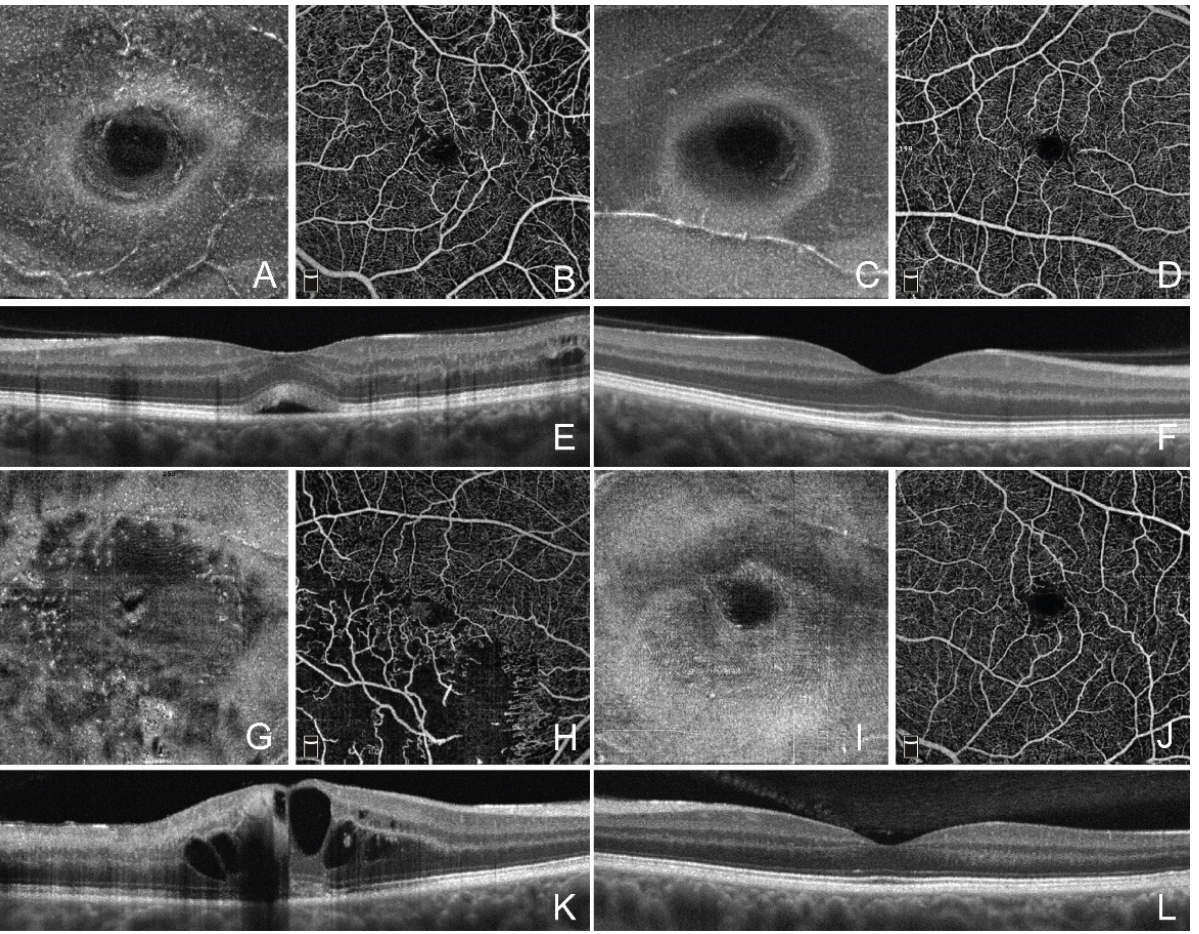
Figure 3. Optical coherence tomography angiography imaging of retinal macrophage-like cells in retinal vein occlusion with and without subfoveal fluid. ( A ) Structural en face optical coherence tomography angiography (OCTA) projection in the RVO eye with macular edema and subfoveal fluid. ( B ) En face OCTA projection of superficial capillary plexus slab. ( C ) Structural en face OCTA projection in the fellow unaffected eye. ( D ) En face OCTA projection of superficial capillary plexus slab in the fellow unaffected eye. ( E ) Cross-sectional OCT image showing macular edema and sub- foveal fluid in the RVO eye. ( F ) Cross-sectional OCT image showing normal macula in the fellow eye. ( G ) Structural en face OCTA projection in the RVO eye with macular edema and no subfoveal fluid. ( H ) En face OCTA projection of superficial capillary plexus slab. ( I ) Structural en face OCTA projection in the fellow unaffected eye. ( J ) En face OCTA projection of superficial capillary plexus slab in the fellow unaffected eye. ( K ) Cross-sectional OCT image showing macular edema without subfoveal fluid in the RVO eye. ( L ) Cross-sectional OCT image showing normal macula in the fellow eye.